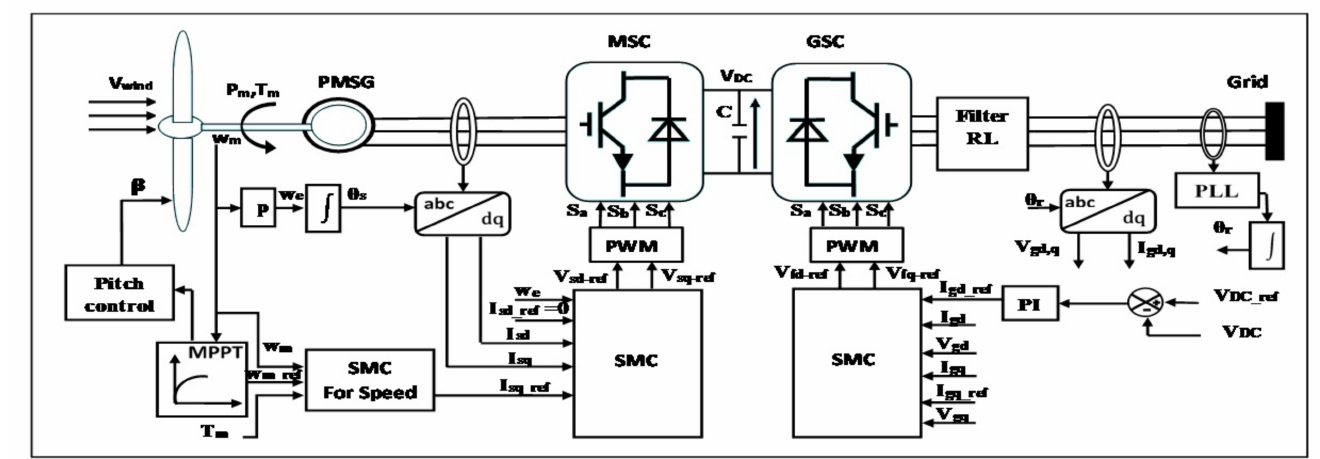
Figure 5. System control